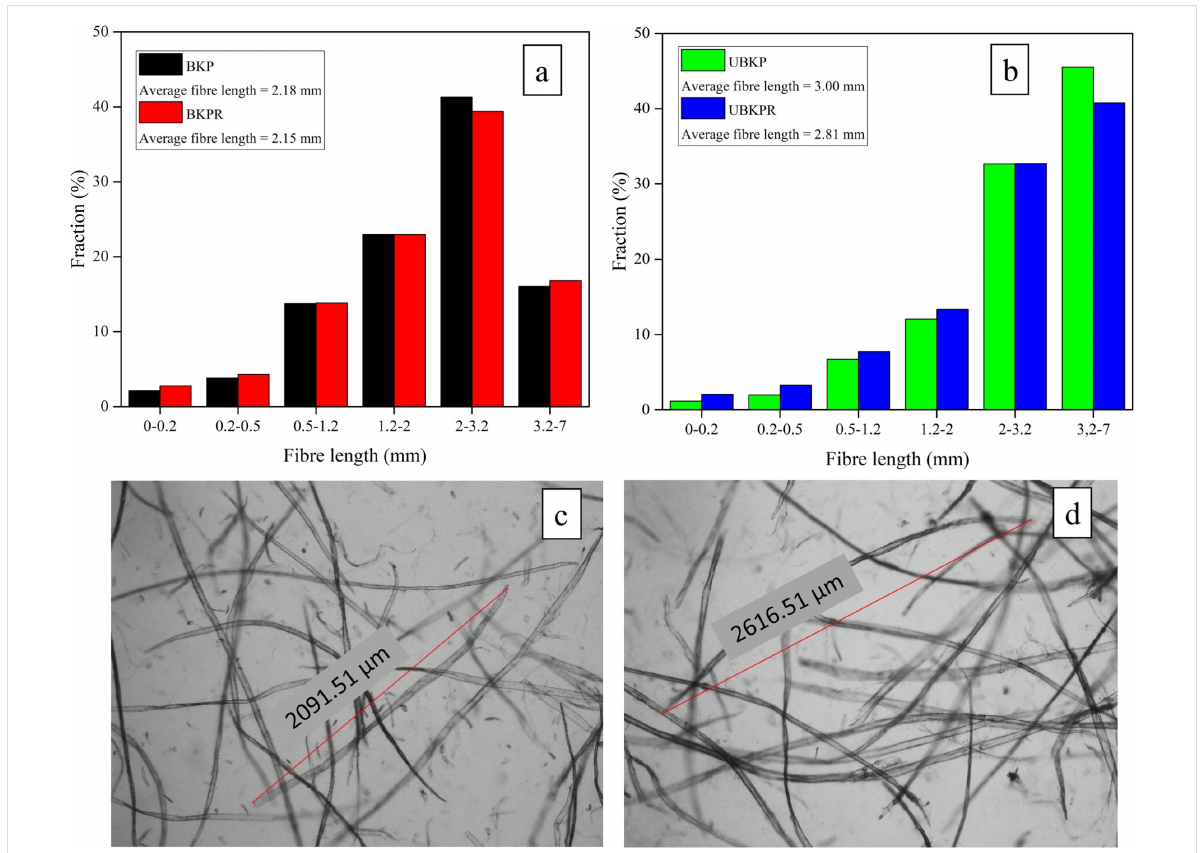
Figure 1: Fiber length distribution of (a) BKP and BKPR and (b) UBKP and UBKPR. Optical microscopy images (10× magnification) of (c) BKPR after 60 min of refining and (d) UBKPR after 90 min of refining.